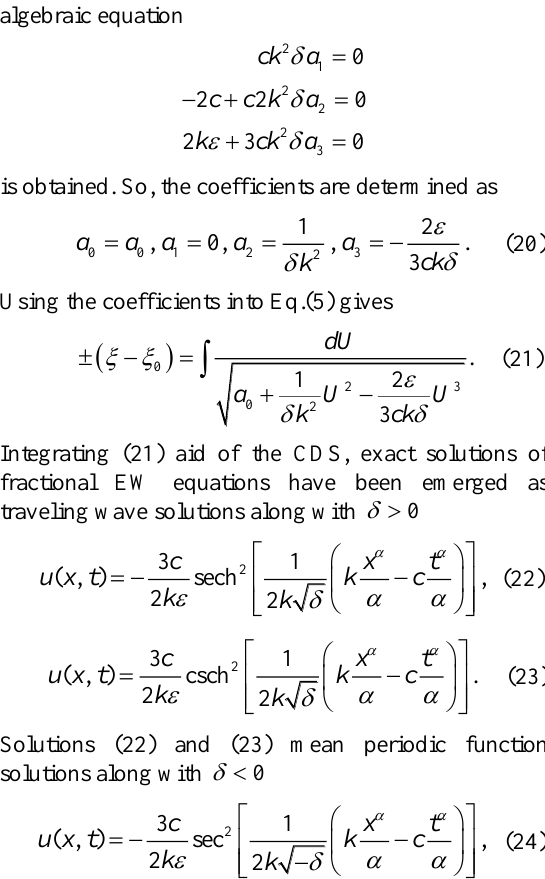
Figure 3. Solution Eq.(22) for 1, 1 c k  = = = = − and indicated 